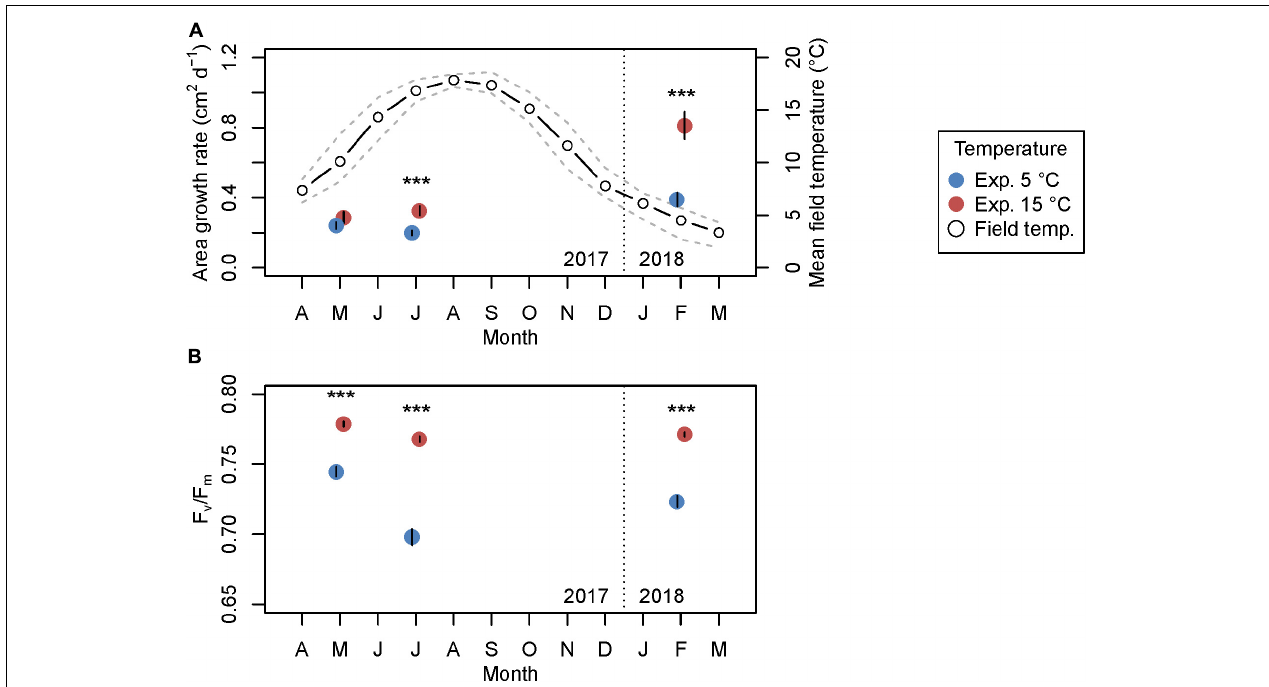
FIGURE 2 | Seasonal growth of wild adult Laminaria digitata meristem discs sampled in May and July 2017, and February 2018 cultivated at 5 and 15 ◦ C for 14 days (experiment 1). (A) Absolute area growth rate over 14 days (primary y-axis, mean values ± SE, n = 20) and field sea-surface temperature around Helgoland (secondary y-axis). Open circles represent mean temperatures per month and dashed gray lines delimit minimum and maximum monthly temperatures for the year 2017/2018 (Helgoland Roads data, Wiltshire et al., 2008). (B) Quantum yield F v /F m at the end of the 14-day experiment (mean values ± SE, n = 20). *** p < 0.001 (Tukey